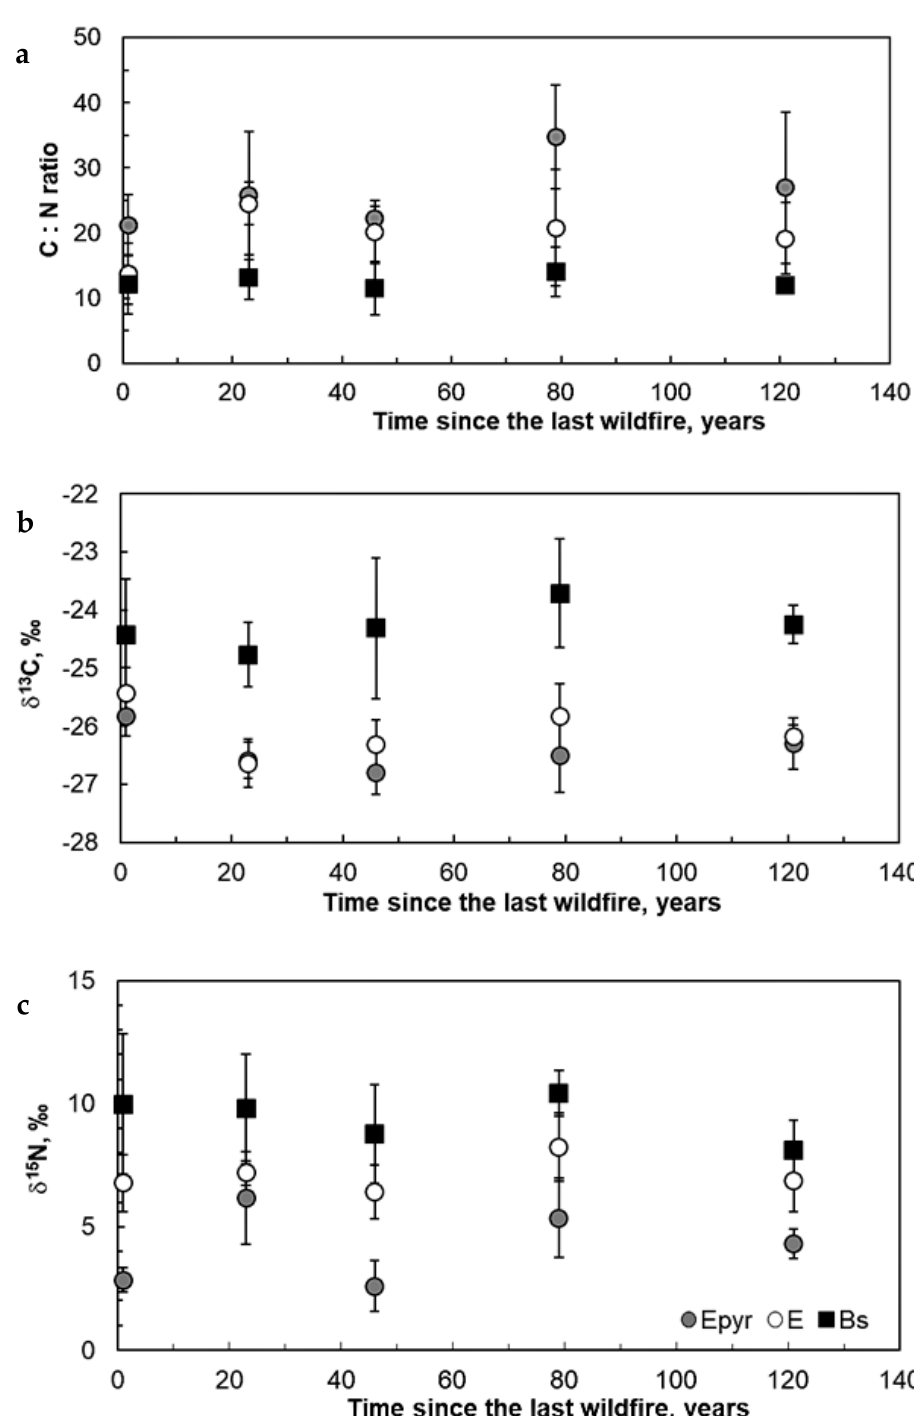
Figure 5. Post-fire dynamics of C:N ratio. ( a ), δ 13 C-SOC ( b ) and δ 15 N ( c ) in different soil genetic horizons: E pyr , E (eluvial) and Bs (illuvial).